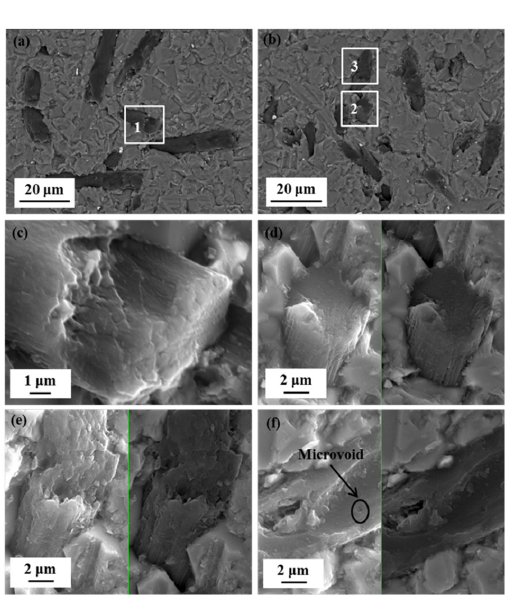
Figure 2. BSE (Backscattered Electron) and SE (Scattered Electron) images: ( a ) along the hot-pressed plane of the composites; ( b ) vertical to the hot-pressed plane of the composites; ( c – f ) in situ transformed PAN-based carbon fibers in the composites and ( c – e ) correspond to high magnification of the areas 1, 2, and 3 in ( a , b ).